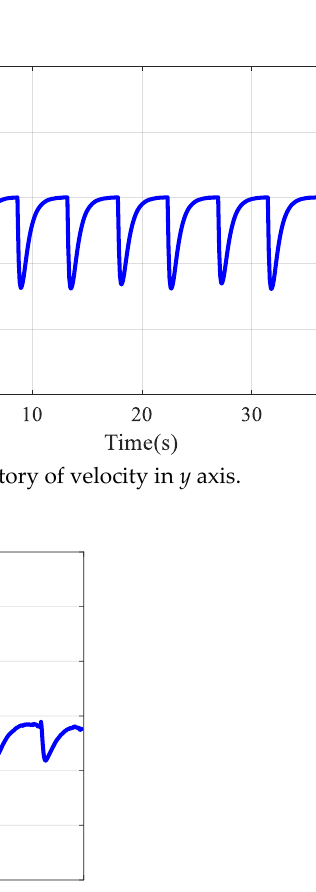
Figure 9. Control commands of controlled AUSV.